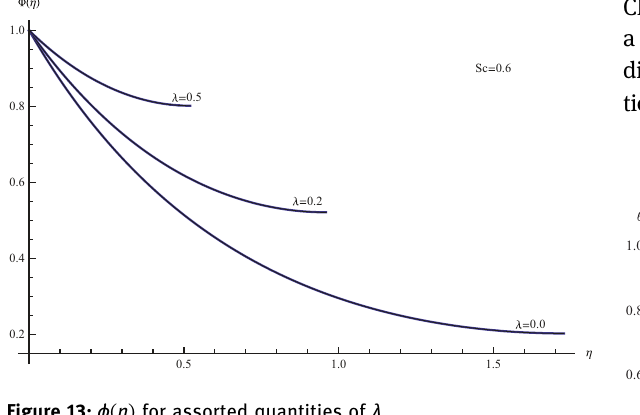
Figure 13: ( ) ϕ η for assorted quantities of λ .